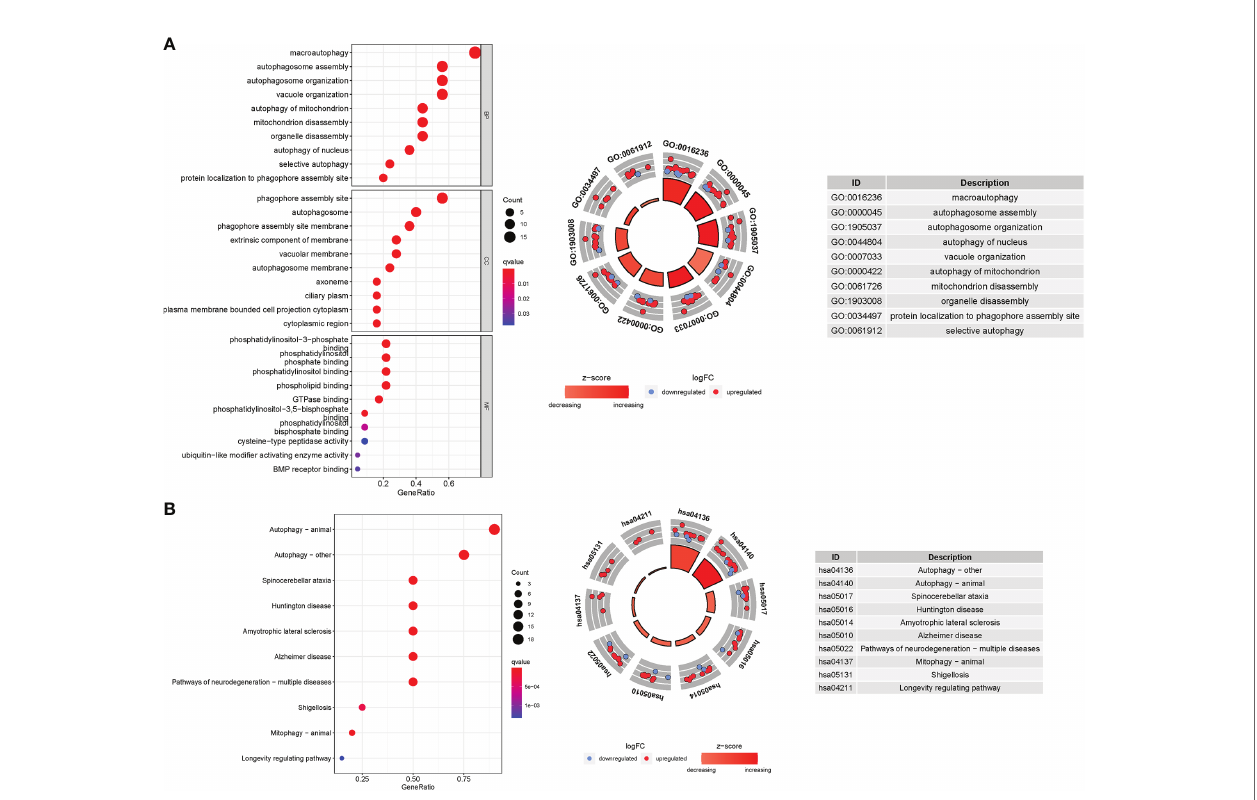
FIGURE 8 | GO and KEGG analyses for genes participating in autophagy. (A) Bubble graph for GO enrichment (the bigger bubble means the more genes enriched, and the increasing depth of red means the differences were more obvious; q-value: the adjusted P value). The GO circle shows the scatter map of the logFC of the speci fi ed gene. (B) Barplot graph for KEGG pathways (the longer bar means the more genes enriched, and the increasing depth of red means the differences were more obvious). The KEGG circle shows the scatter map of the logFC of the speci fi ed gene. The higher the Z-score value indicated, the higher expression of the enriched